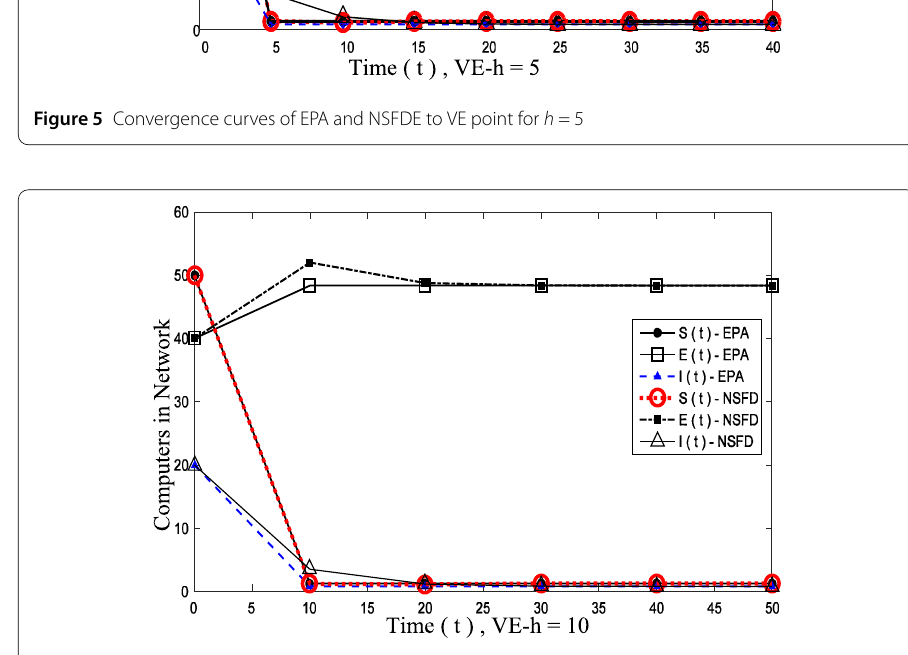
Figure 6 Convergence curves of EPA and NSFD to VE point for h = 10